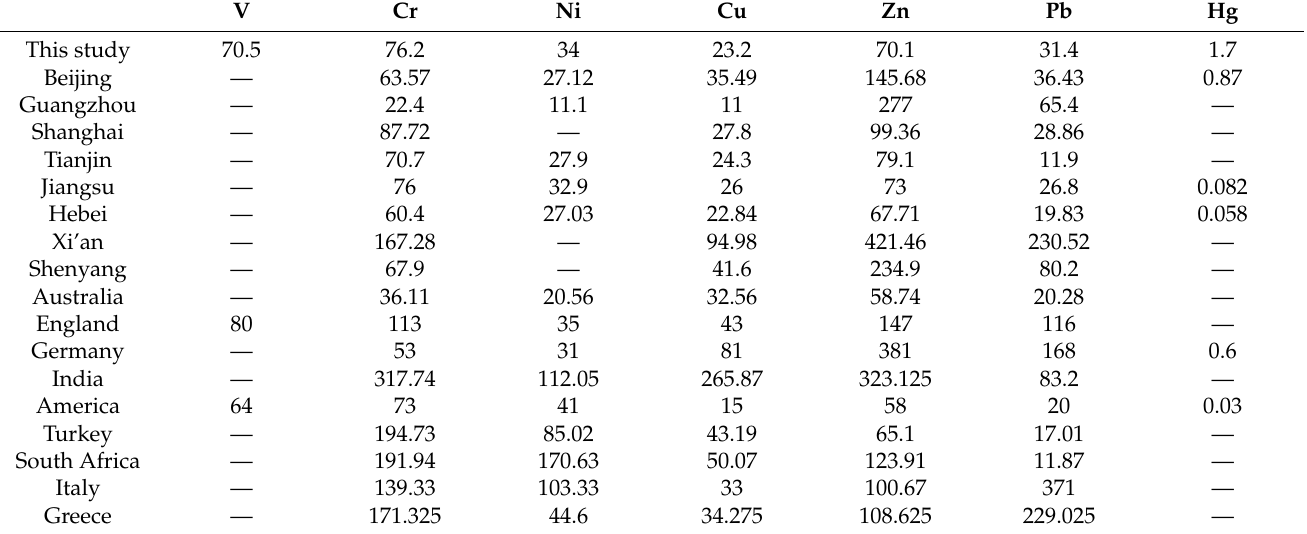
Table 7. Comparison of soil metal concentrations in Linyi City with those in Chinese cities and other countries in the